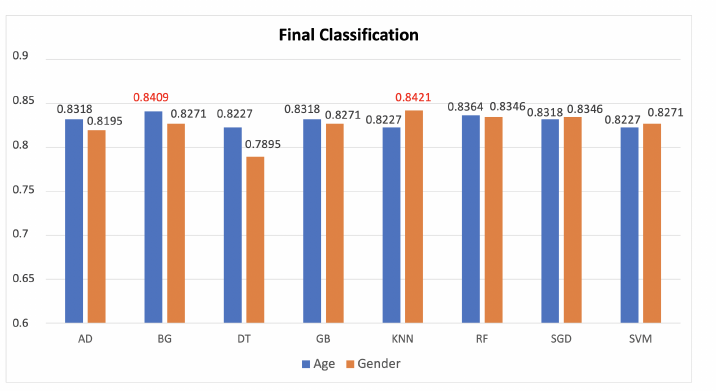
Figure 7. The results of the classifiers are obtained using the combination of the best two scores of SVM and Random Forest for age classification, and of Gradient Boosting and SVM for gender one. In red are reported the best accuracies for age and gender, respectively.